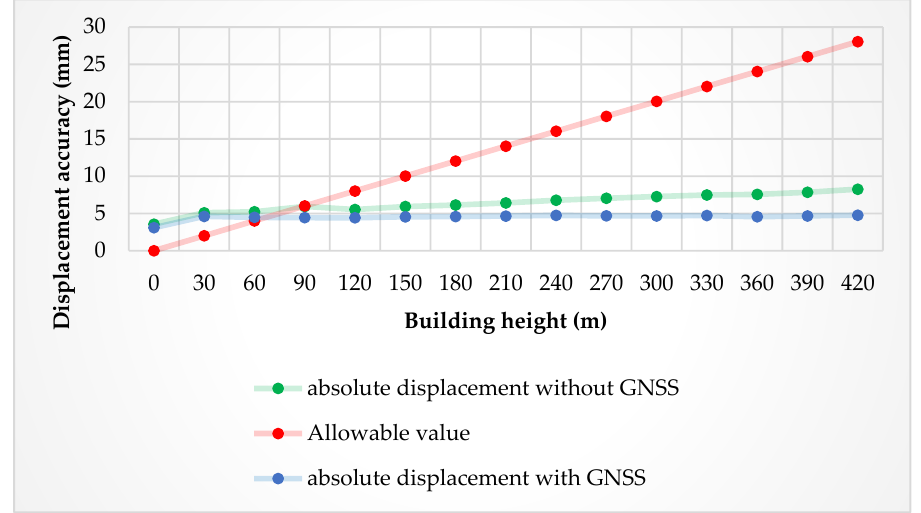
Figure 30. Simulation results comparison for GNSS-accompanied case.